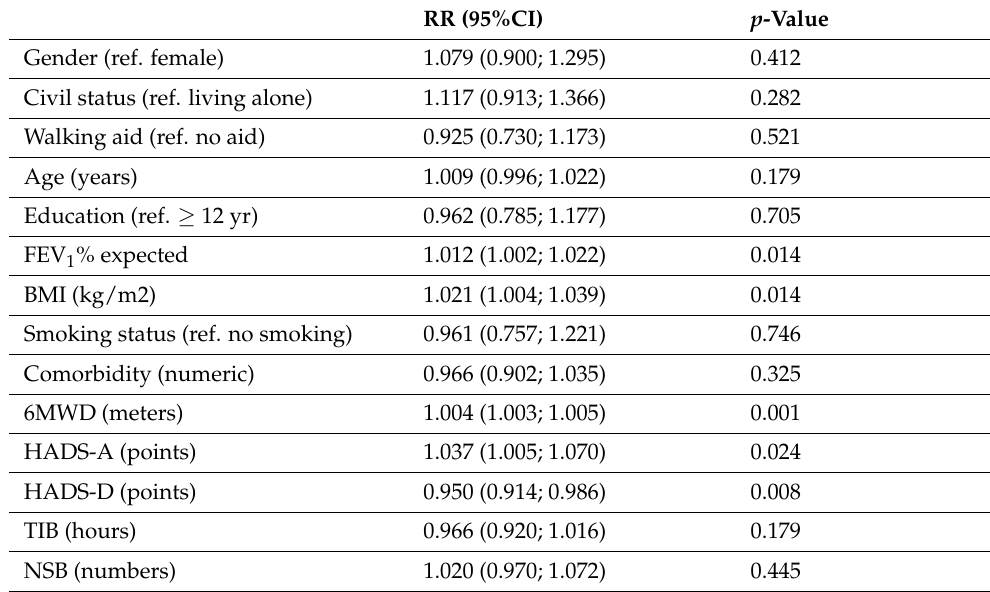
Table 3. Negative binomial regression and rate ratio for number of steps per